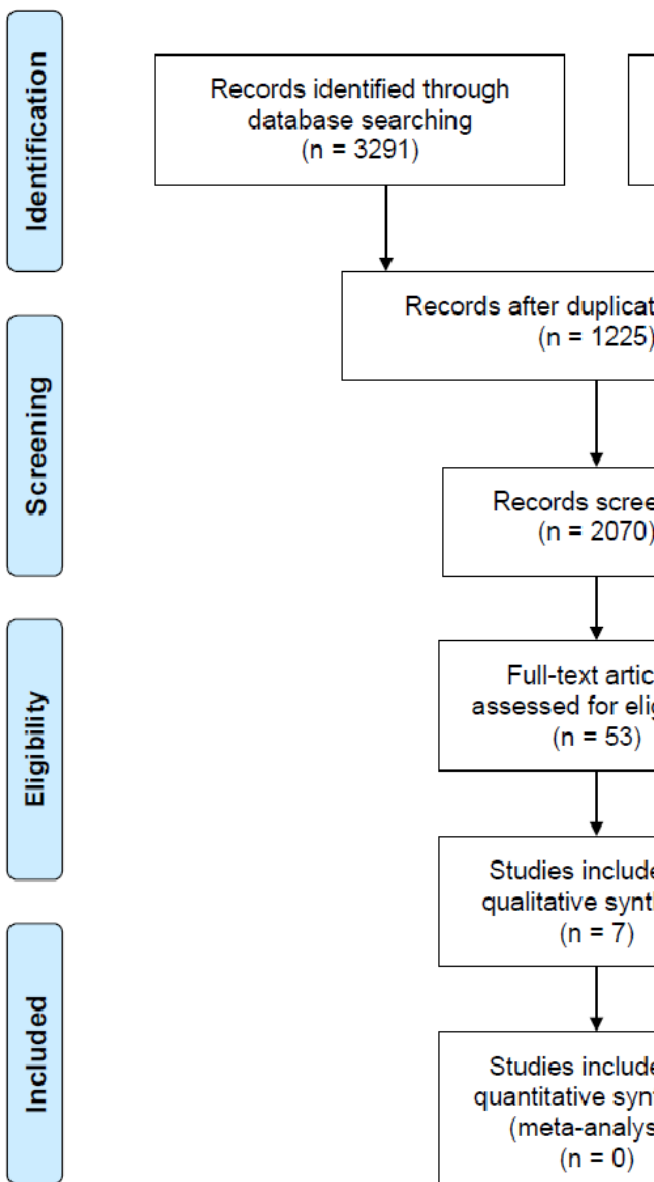
Figure 1. PRISMA (Preferred Reporting Items for Systematic Reviews and Meta-Analyses)